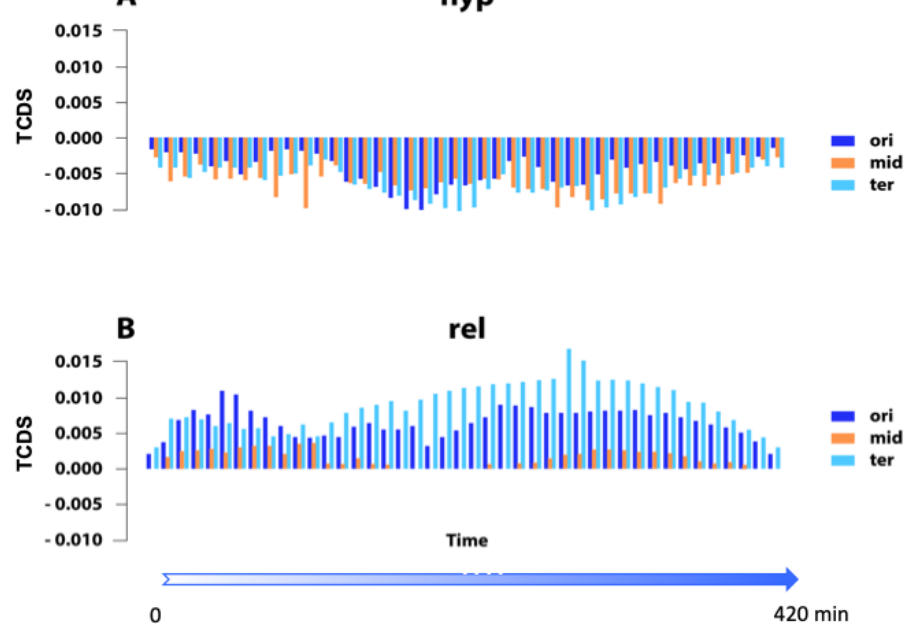
Figure 2. TCDS strength measured at the gene promoter regions during the growth cycle of E. coli grown in batch culture. The entire dataset was divided into three equally sized sets of OriC-proximal (ori), intermediate (mid), and Ter-proximal (ter) genes. TCDS was determined assuming a 10 kb range as previously described [170], whereby the impact of TCDS is exponentially decreasing with distance to its originating gene. ( A ) Average TCDS of neighboring transcription for hyp genes [31] activated under conditions of hyper-negative DNA supercoiling. ( B ) Average TCDS of neighboring transcription for rel genes [31] activated under conditions of DNA relaxation. TCDS was measured at 10 min intervals during the entire growth cycle (0–420 min) using the RNA-Seq data from [12]. Abscissa—time (in minutes) after inoculation of cells in the fresh medium. Ordinate—strength of TCDS; positive values indicate impact of positive superhelicity, negative values indicate impact of negative superhelicity. For growth conditions see legend in Figure 1.